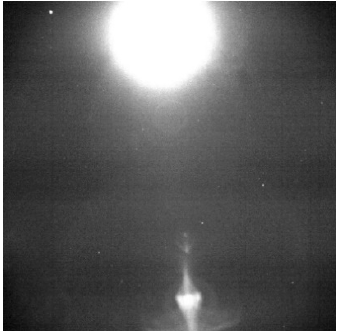
Figure 1. Stray light in a star image.